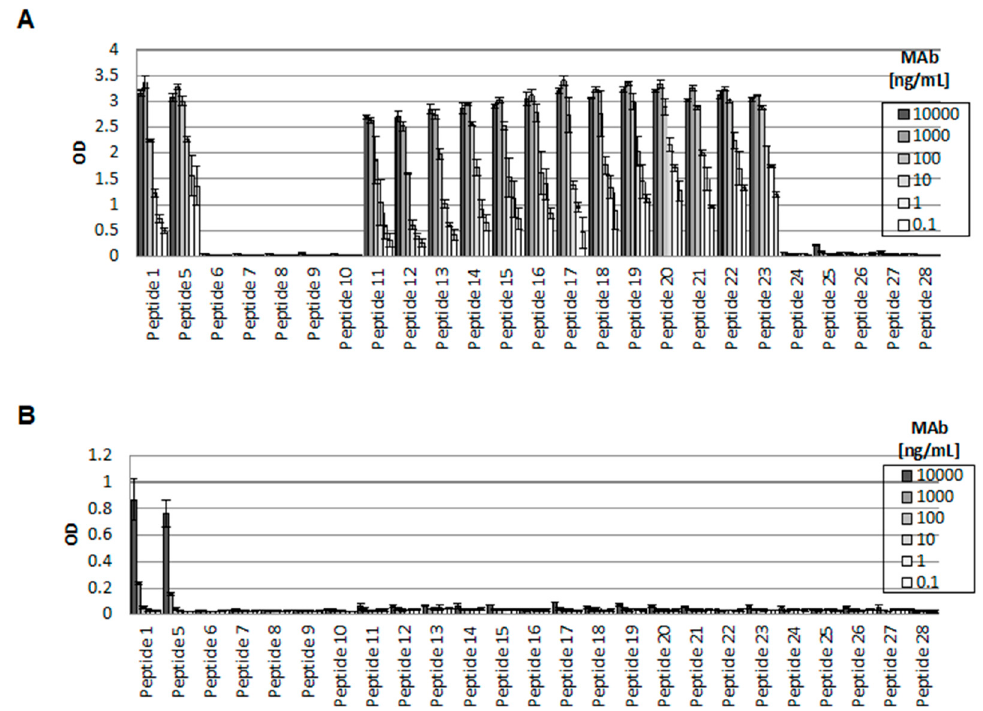
Figure 3. A particular region of K8 is essential for the regulation of invasion and apoptosis. ( A , B ) Elisa experiments conducted to determine D-A10 MAb ( A ) or M20 ( B ) reactivity to K8 peptides 1 and 5 to 28. The sequence of each peptide is described in the Table 1. OD: optical density. Table 1. Number and sequence of keratin 8 (K8) peptides targeted by D-A10 and M20 monoclonal antibodies (MAbs).